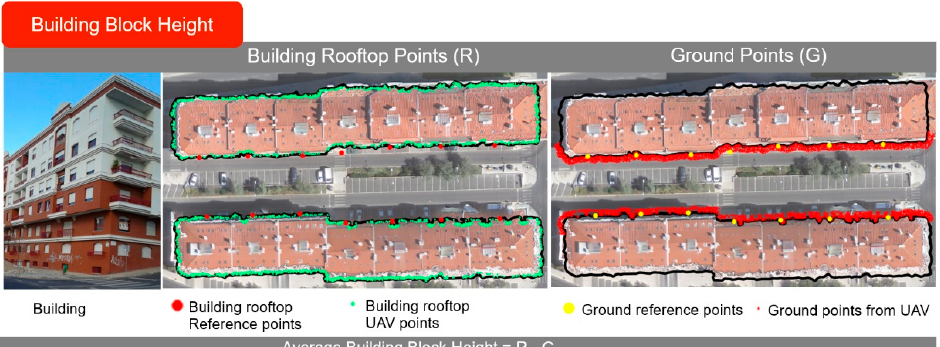
Figure 6. Points selected (eave roof and ground) for each block in area A.